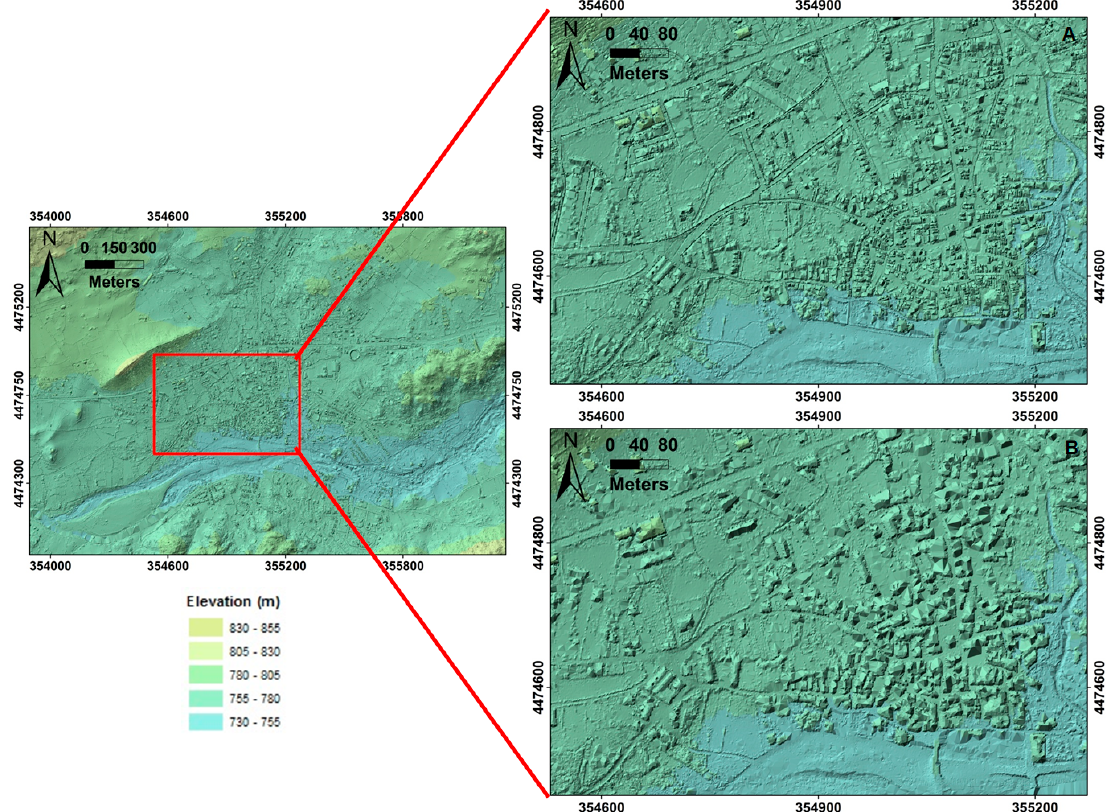
Figure 8. General view of the TIN of the study site. ( A ) shows a zoom-in of the same urban area including breaklines; ( B ) shows a zoom-in of the urban area without breaklines. including breaklines; ( B ) shows a zoom-in of the urban area without